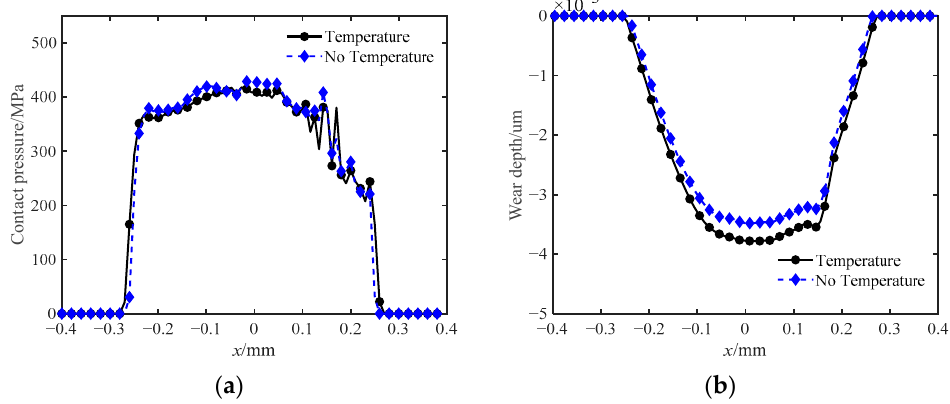
Figure 8. Effect of temperature on contact pressure and wear depth. ( a ) Contact pressure; ( b ) wear depth.